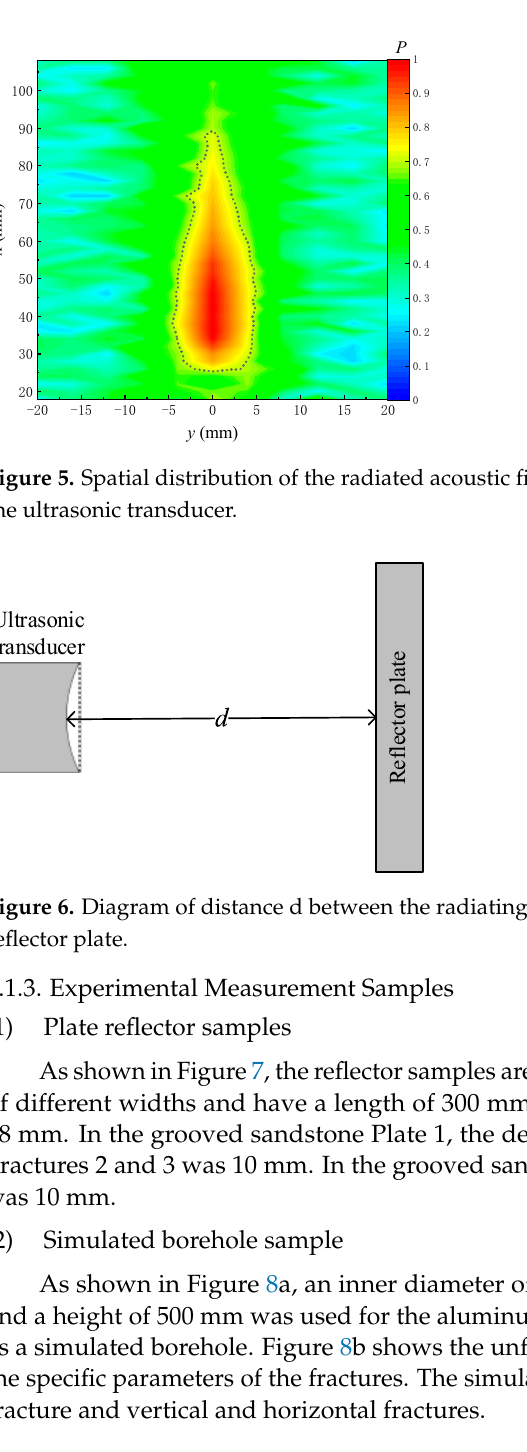
Figure 4. Schematic of the spatial distribution in the radiated acoustic field experiment.